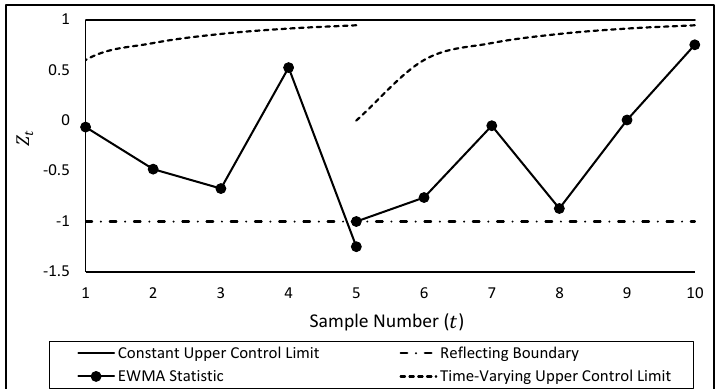
Fig. 1. EWMA control chart with constant and time-varying control